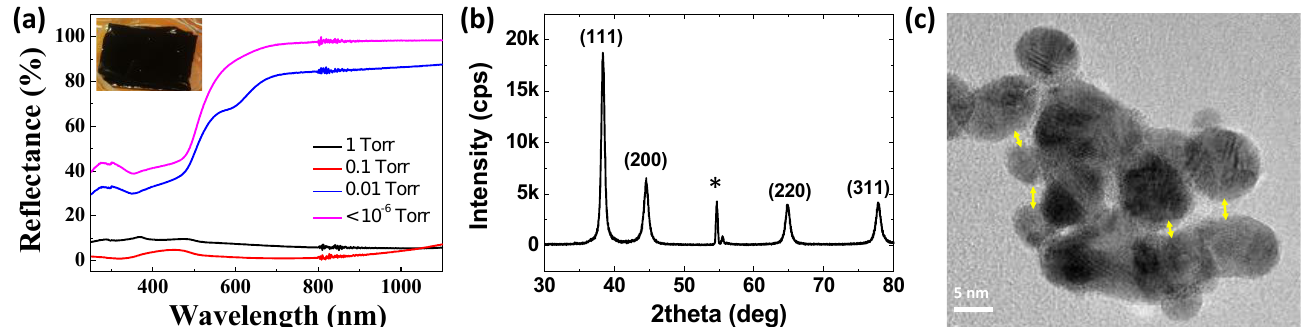
Figure 2. ( a ) Reflectance of Au thin film nanostructures grown at different pressure. Inset displays the digital image of the nanoporous ‘black gold’ grown at 1 Torr; ( b ) GIXRD analysis of the highly porous Au thin film grown at 1 Torr. All the reflections are labeled according to the JCPDS reference, and the star (*) indicates the reflections from the Si substrate; ( c ) high-resolution TEM image of the nanoparticle aggregate from nanoporous Au grown at 1 Torr. Lots of nano-gaps are found between the nanoparticles, as indicated by the yellow arrows.